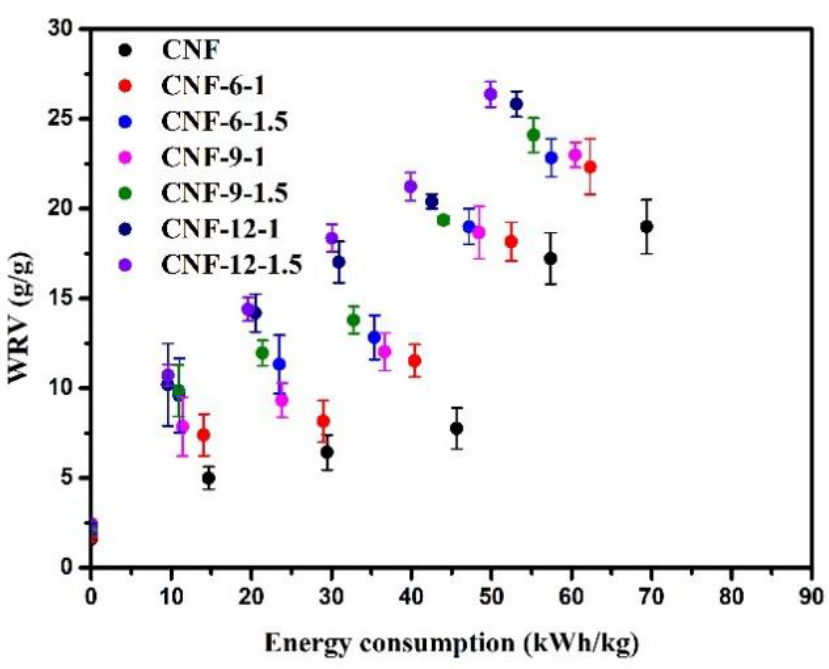
Figure 3. Water retention value (WRV, g/g) of CNF samples as a function of energy consumption (kWh/kg) in the supermasscolloider.